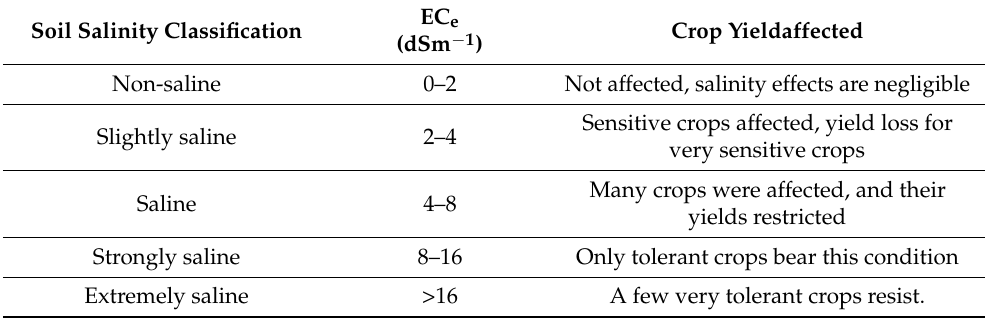
Table 1. Soil salinity classifications based on EC e (dS m − 1 ) and effects on different crops. Soil Salinity Classification